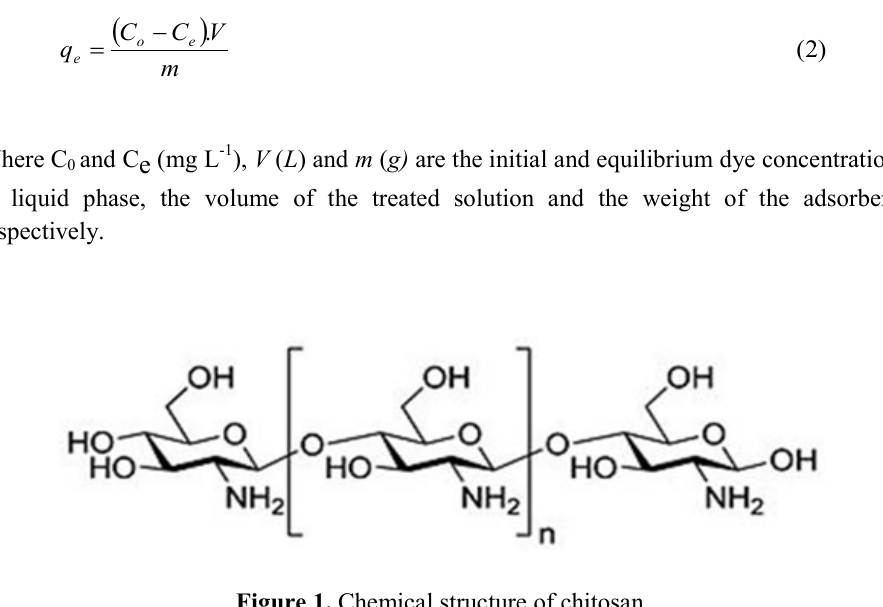
Figure 1. Chemical structure of